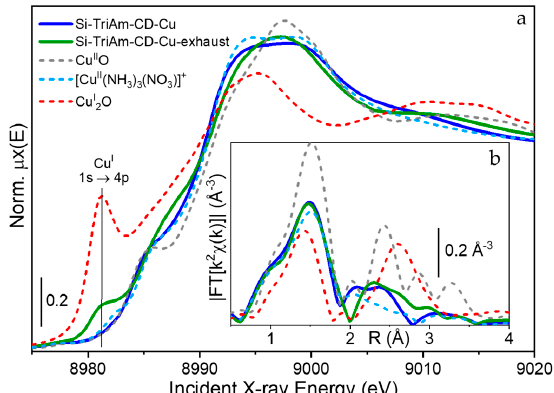
Figure 6. Cu K-edge ( a ) X-ray absorption near edge structure (XANES) and ( b ) extended X-ray absorption fine structure (EXAFS) spectra of Si-TriAm-CD-Cu and Si-TriAm-CD-Cu five times reused reported as thick solid lines. The spectra of the sample are compared to the ones of selected model compounds, namely Cu II O, Cu I 2 O, and [Cu II (NH 3 ) 3 (NO 3 )] + , reported as thin dashed lines. XAS reveals that as-prepared Si-TriAm-CD-Cu exclusively contains Cu(II) species, based on the absorption edge position, as well as on the presence of a characteristic rising-edge peak at ca. 8986 eV. Indeed, this XANES feature, observed for both Cu II O and [Cu II (NH 3 ) 3 (NO 3 )] + model compounds is assigned to three/four-fold coordinated Cu II metal centers [59,61]. The XANES line shape observed for Si-TriAm-CD-Cu in correspondence of the intense resonance at ca. 8995 eV (“white-line” peak region) resembles the one observed in the [Cu II (NH 3 ) 3 (NO 3 )] + , pointing to a possible mixed ligation to both O (e.g., from OH groups), and N atoms (most likely from the N 1 -(3-Trimethoxysilylpropyl)